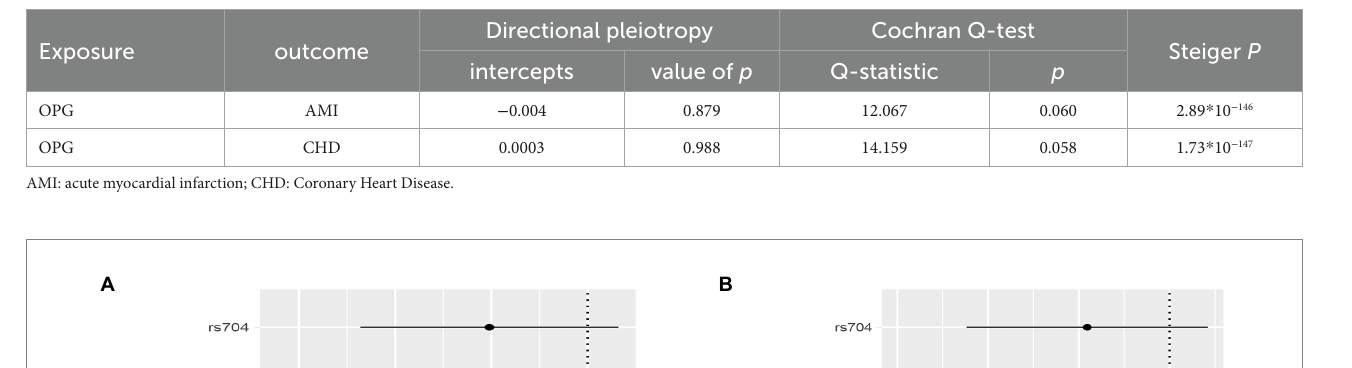
TABLE 2 Sensitivity analyses with complementary methods.